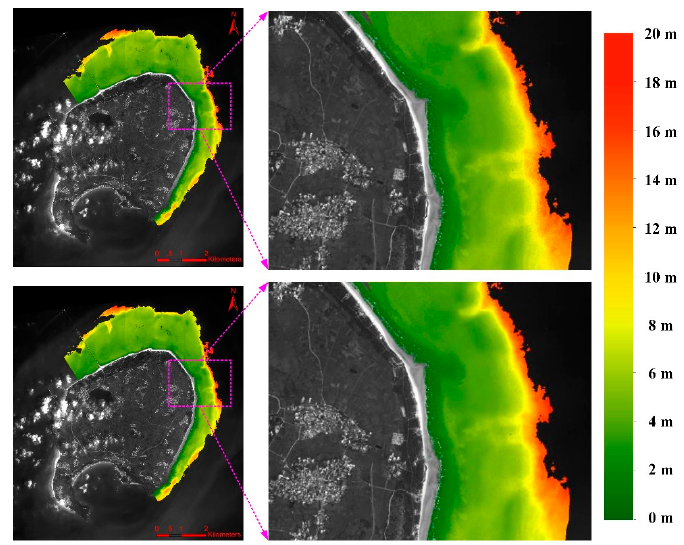
Figure 10. The water depths estimated by the WV-3 image: ( Top ) before the global adjustment; and ( Bottom ) after the global adjustment.